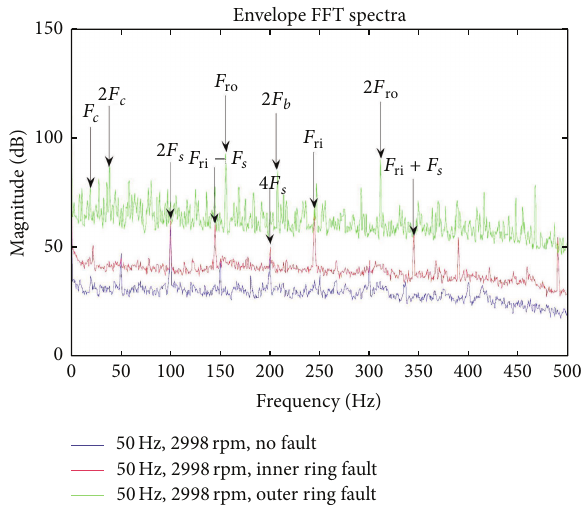
Figure 6: Nominal, inner defect, and outer defect spectra of 50Hz motor input, free load condition, and axial vibration